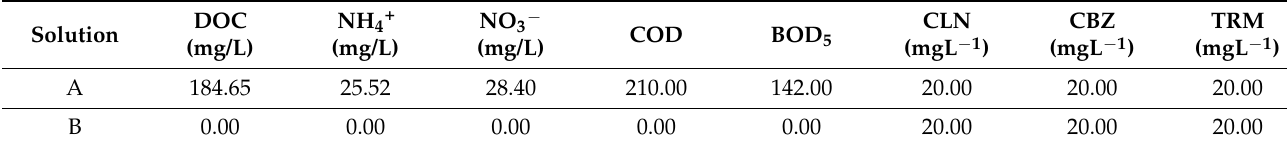
Table 3. Characteristics of solutions A and